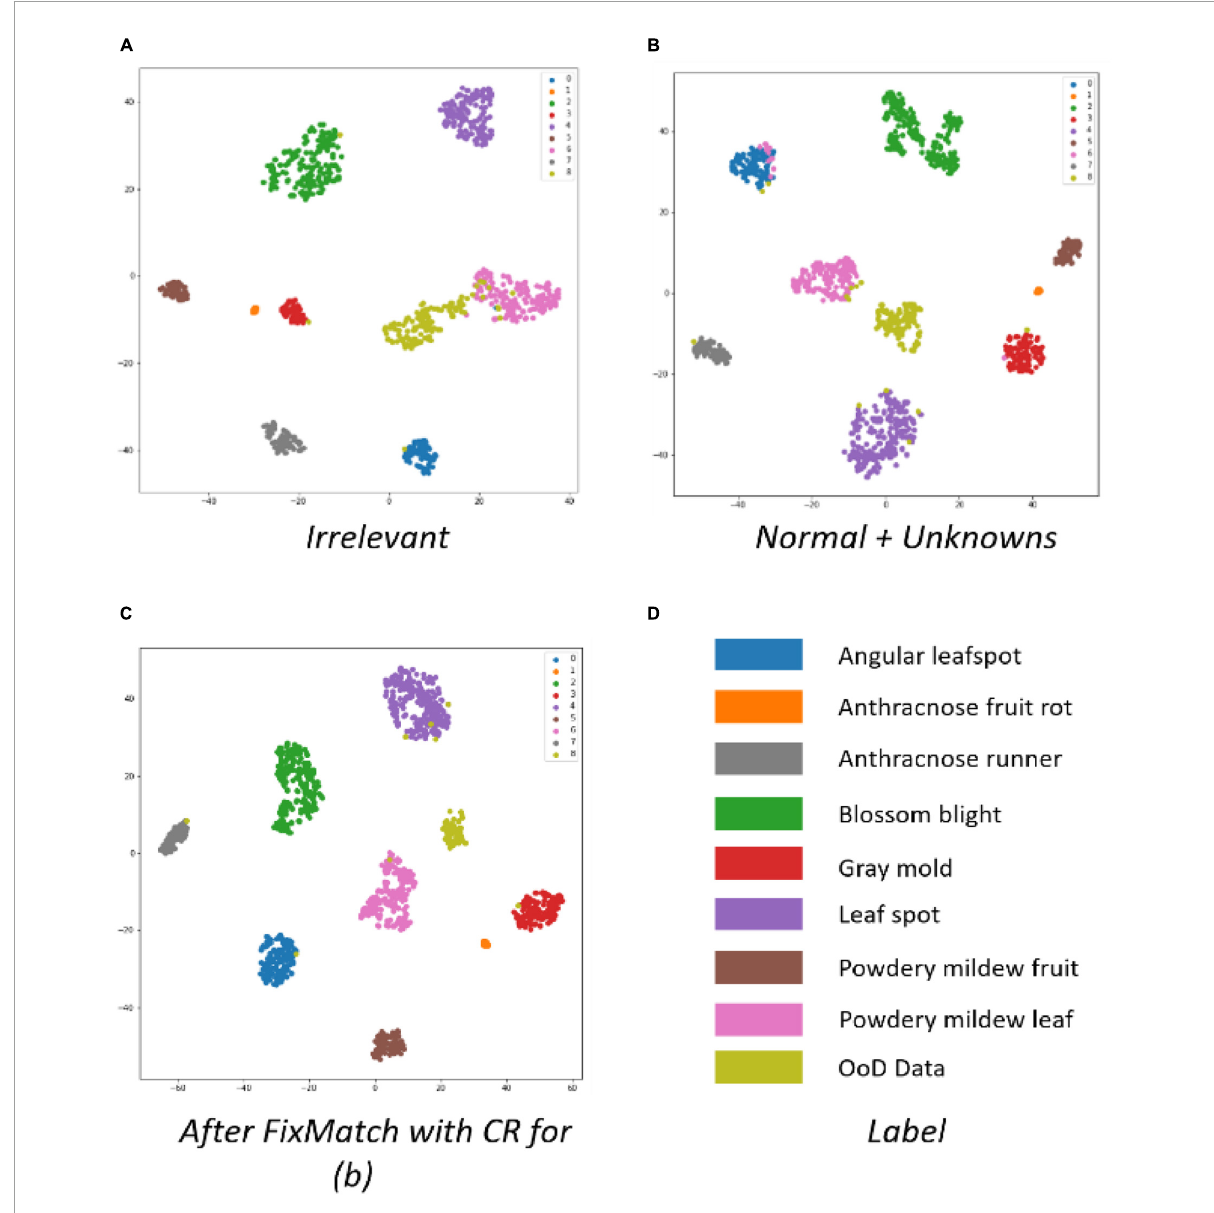
FIGURE9 Comparison of cluster structures using